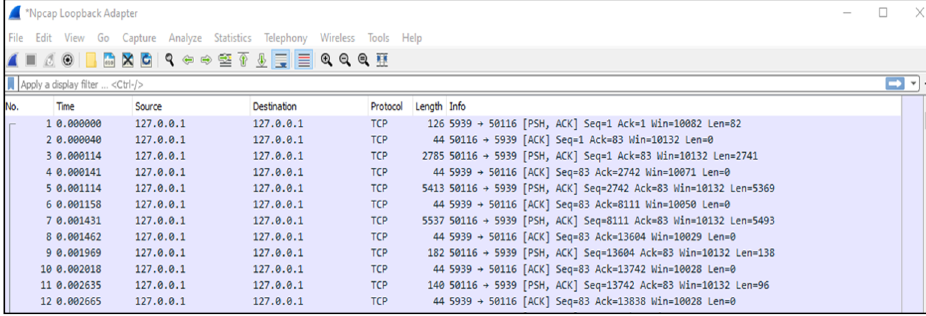
Figure 14. SNORT log file in Wireshark.